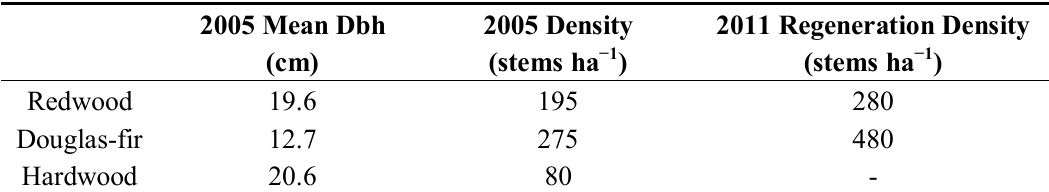
Table 1. Summary data from twelve 0.04 ha plots in young stands at Headwaters Forest Reserve, California. Mean dbh and density for all trees >7.62 cm dbh collected in 2005 after precommercial thinning in 2004. Regeneration counted in 2011 did not include trees tallied in